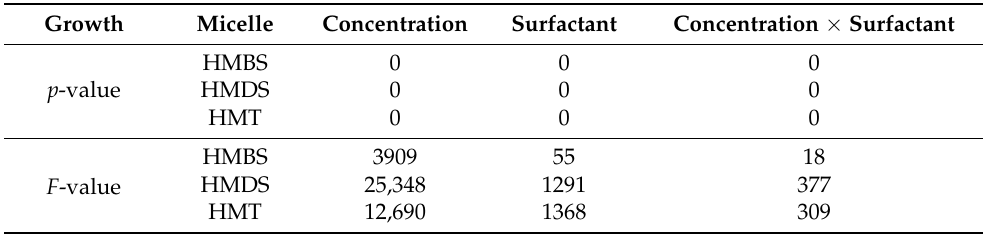
Table 3. Interaction of the sample concentration and the surfactant towards the Ganoderma boninense growth.